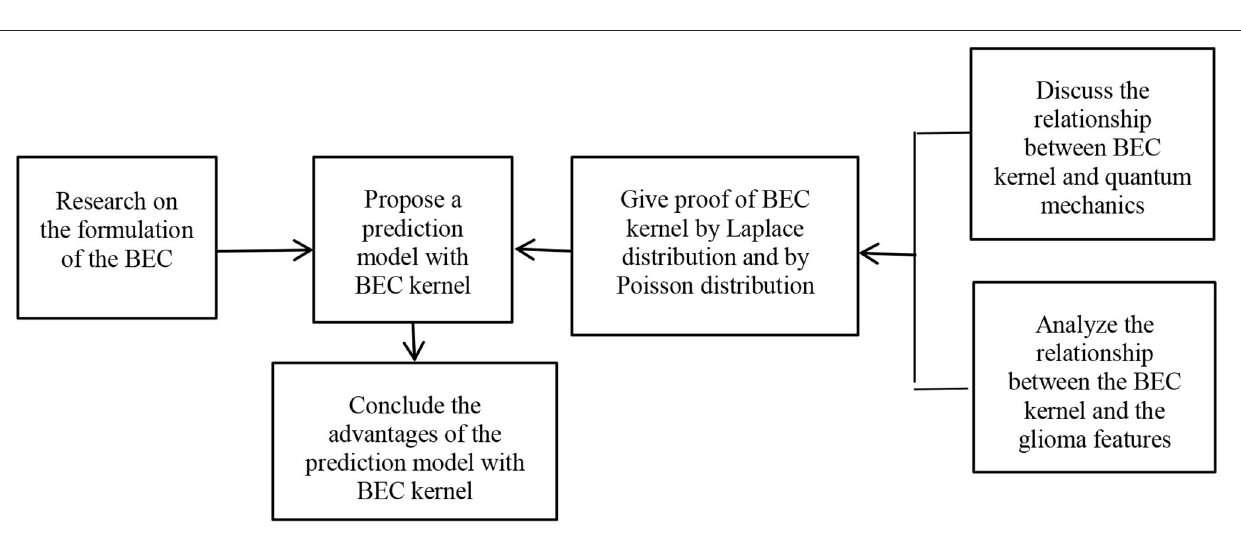
Figure 2 highlights similar properties in the shape of Bose- Einstein Condensate (BEC) and